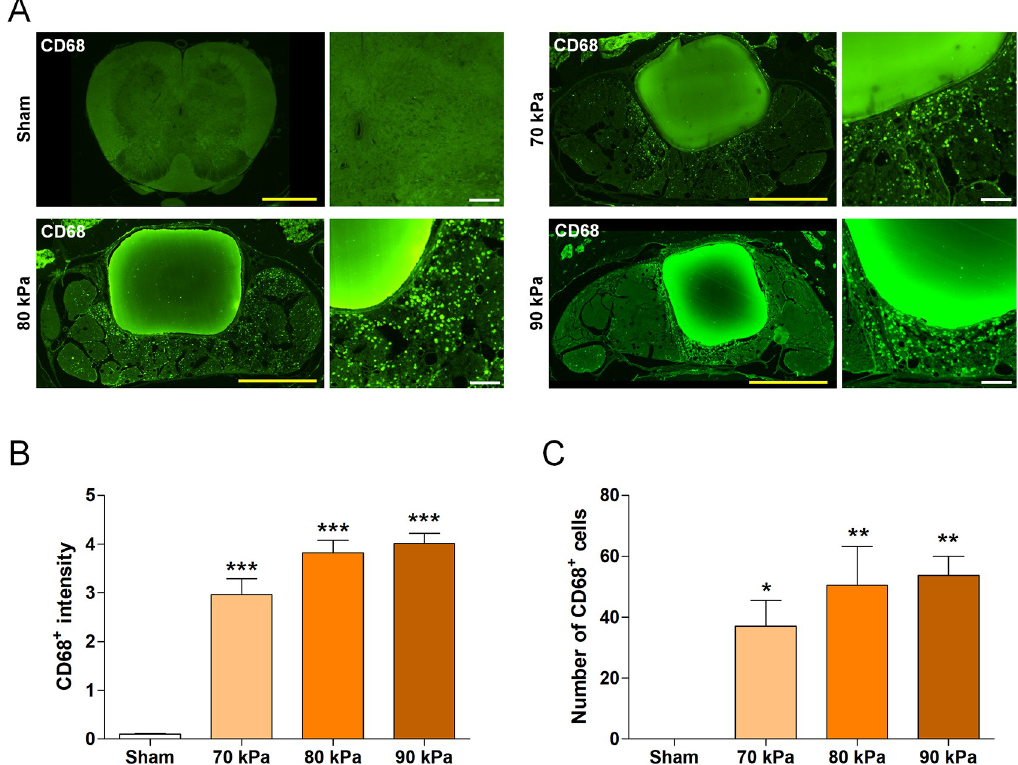
Fig 2. Inflammation assessment using the LSS model. (A) Representative immunofluorescence images of CD68 + macrophages in the spinal cord. Yellow scale bars = 1 mm and white scale bars = 100 μ m. (B, C) Quantitative analyses of the (B) intensity and (C) number of CD68 + macrophages in the sham and LSS groups (n = 4 per group). Data are expressed as the means ± SEM. � P < 0.05, �� P < 0.01, and ��� P < 0.001 compared with the sham group analyzed by a one-way ANOVA with Tukey’s post-hoc